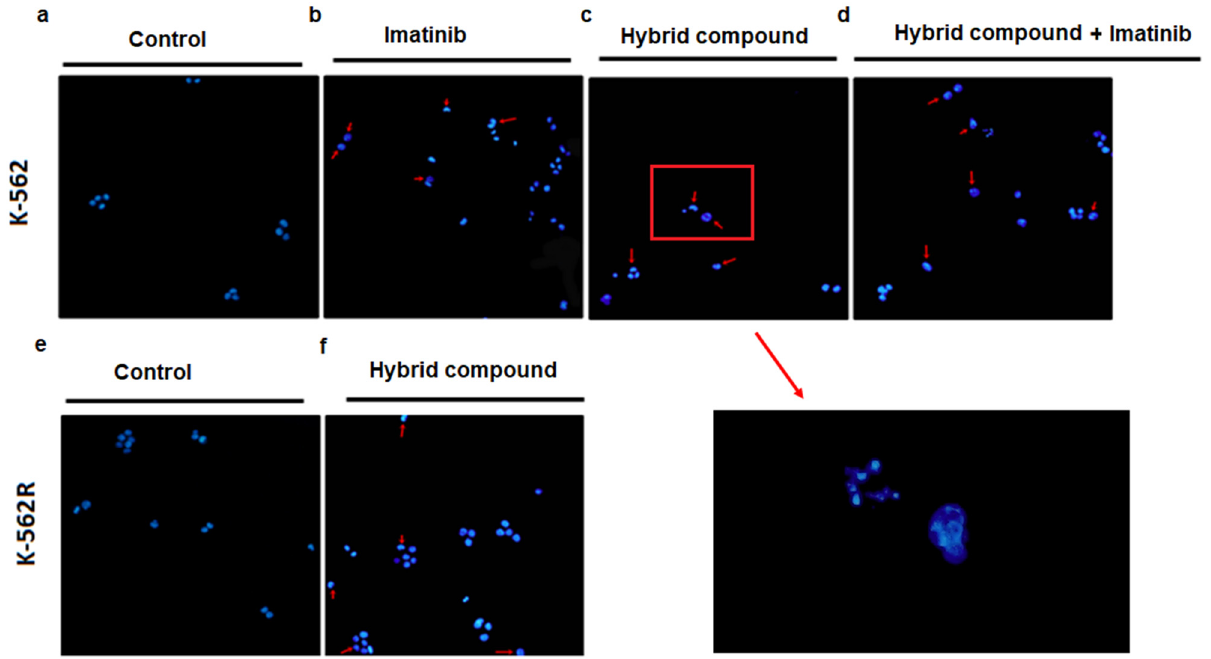
Figure 4. Apoptotic morphological changes observed by DAPI staining after 48 h of treatment of K-562 cells with ( a ) only RPMI-1640 medium, ( b ) imatinib, ( c ) hybrid compound and ( d ) a combination of hybrid compound and imatinib, and of K-562R cells with ( e ) only RPMI 1640 medium or ( f ) hybrid compound. Highlighted, the image allows the visualization of the apoptotic bodies. Classical apoptotic features such as cell shrinkage, blebbing and fragmented nuclei are highlighted (arrows).